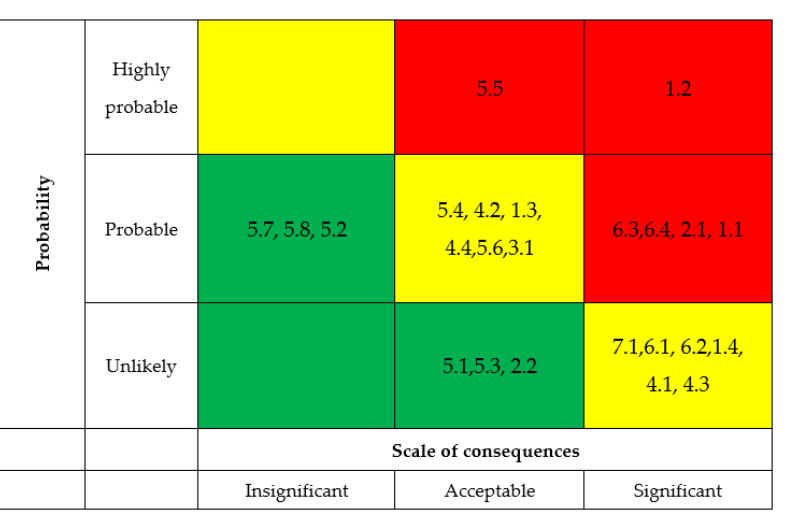
Figure 5. The principles of implementing oil and gas projects for the preservation of ecosystems. To implement the formulated principles of the sustainable development of the Arctic ecosystem, the authors have also developed recommendations for the state and business ensuring the ecologically balanced development of the Arctic. In particular, the authors consider the exceptional vulnerability of the harsh Arctic nature and address the problems of maximum preservation of the biodiversity of flora and fauna and their natural habitats (Table 6). The table is organized as follows: the first column shows recommendations for businesses, while the second one provides the risk/processes whose probability and con- sequences could be reduced by considering the recommendations.